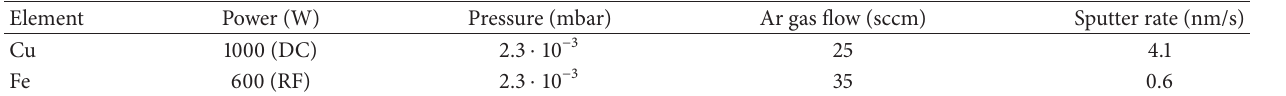
Table 1: Sputtering parameters.